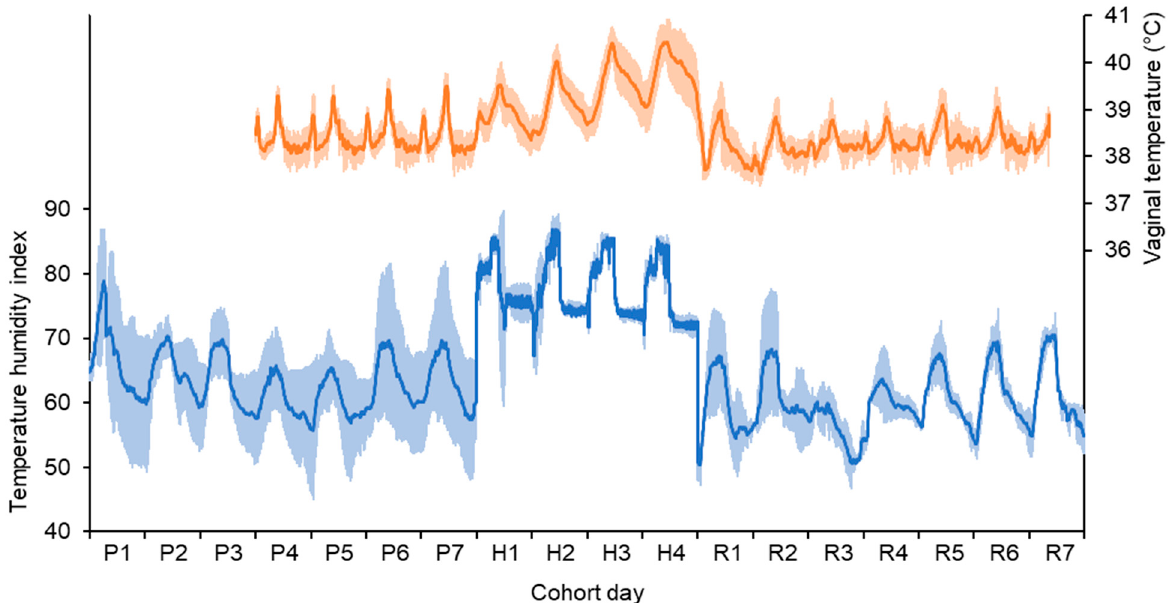
Figure 1. Mean environmental conditions experienced by the cows before (P), during (H), and after (R) a heat challenge (blue line, light blue band shows ± one standard deviation about the mean) and the mean vaginal temperature of all cows (orange line, light-orange band shows ± one standard deviation about the mean). The heat challenge was generated in controlled-climate chambers, and the cows were kept in ambient conditions before and after the heat